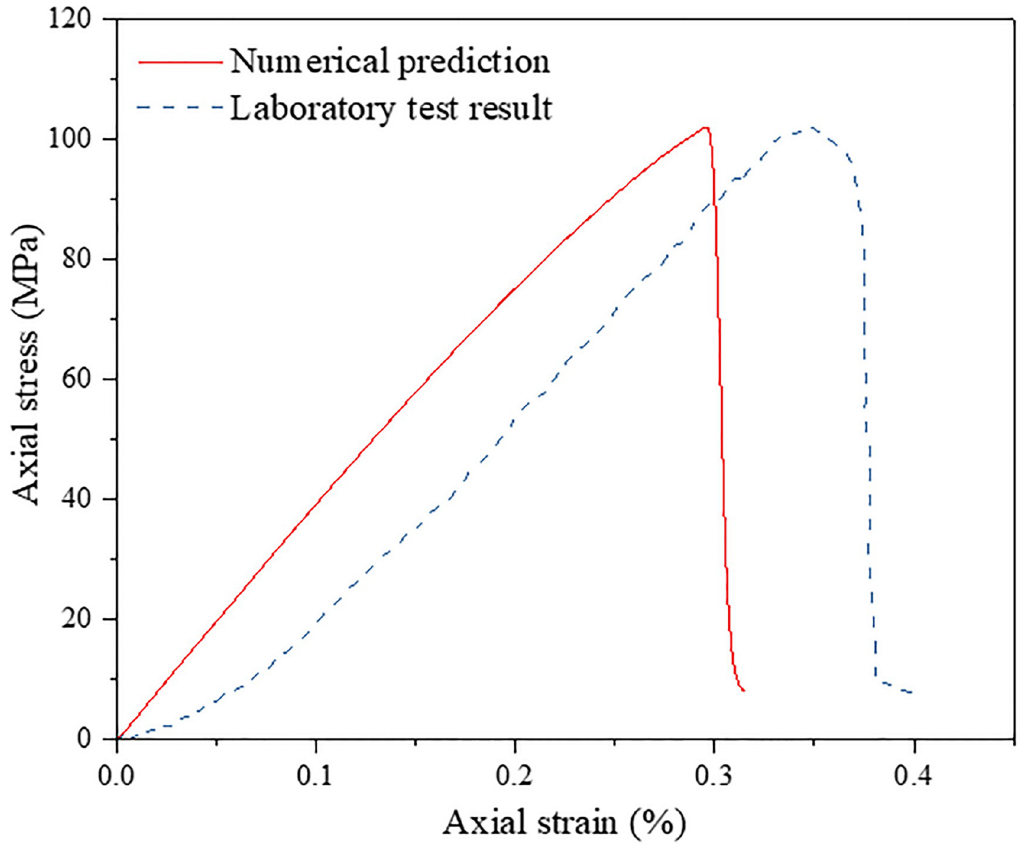
Fig 8. Comparison of the axial stress–strain curves of the granite sample between the laboratory test and numerical prediction.